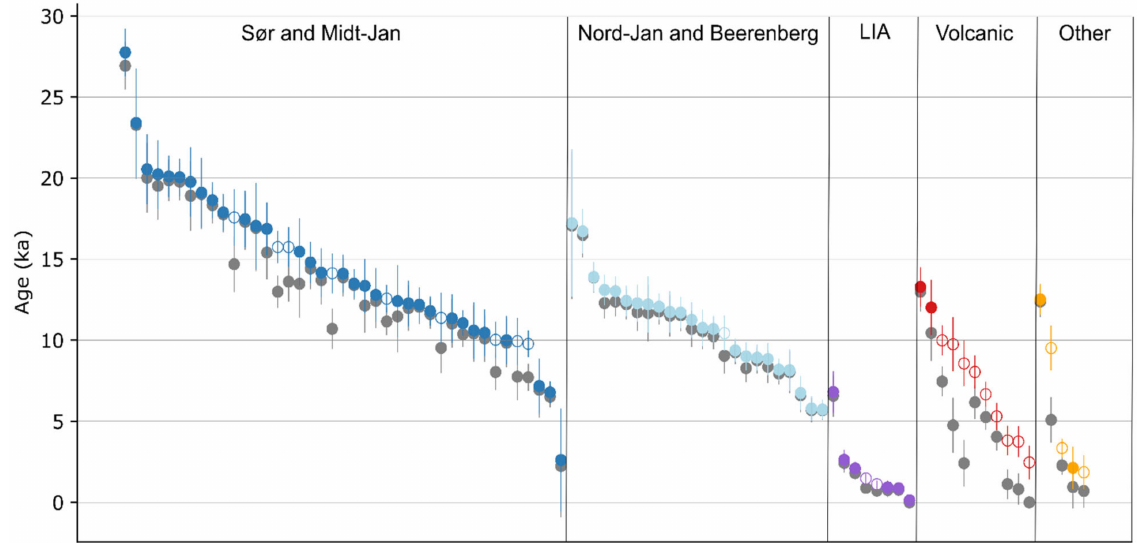
Figure 5. Exposure ages calculated assuming that the rock formation age equals the exposure age (i.e., young rock ages) in color, and below (in grey) the ages of the same sample calculated with the assumption that the background 36 Cl had reached equilibrium. The samples have been separated into sample setting and region and sorted from the oldest to the youngest within each region. The uncertainties are the internal uncertainties (1 standard deviation). Samples where the equil. age differs by less than 1 standard deviation from the young rock age are indicated by filled circles, and if they differ by more than 1 standard deviation, indicated by unfilled